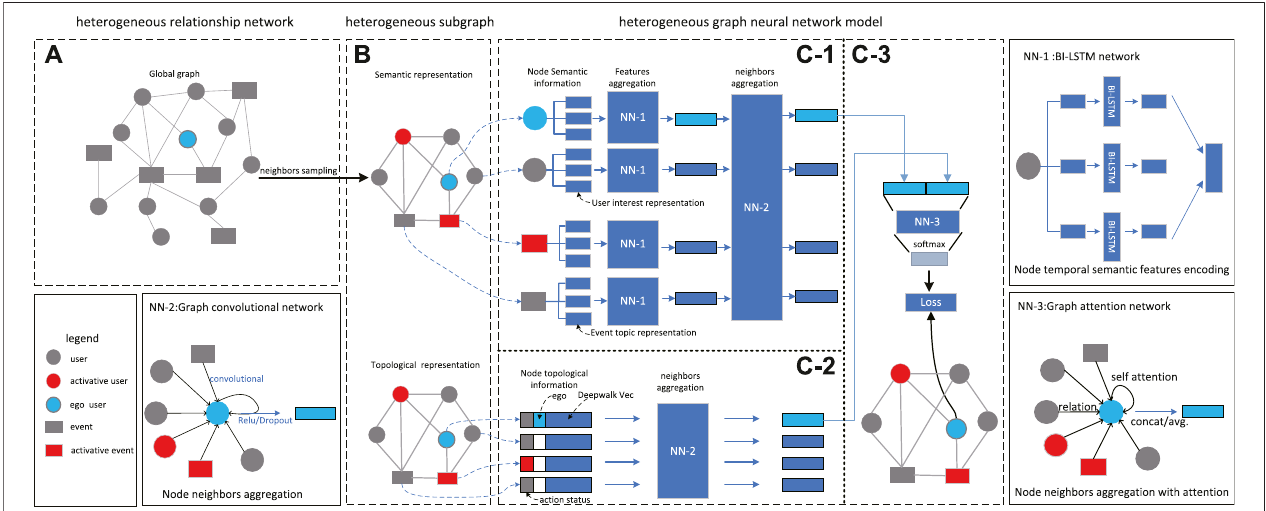
FIGURE 2 | Model framework of HetInf: It fi rst (A) constructs heterogeneous relational networks with attributes), next (B) samples fi x sized heterogeneous neighbors for each node, then aggregates the attribute features and topological features of the sampled heterogeneous neighbors via (C-1) and (C-2), and fi nally optimizesthemodel via (C-3).NN-1:Bi-LSTM,usedtoaggregatesemanticfeaturesbasedontimeseries;NN-2:GCNnetwork,usedtoaggregateheterogeneousnode attributes; and NN-3: GAT network, used to learn the weights of interaction between